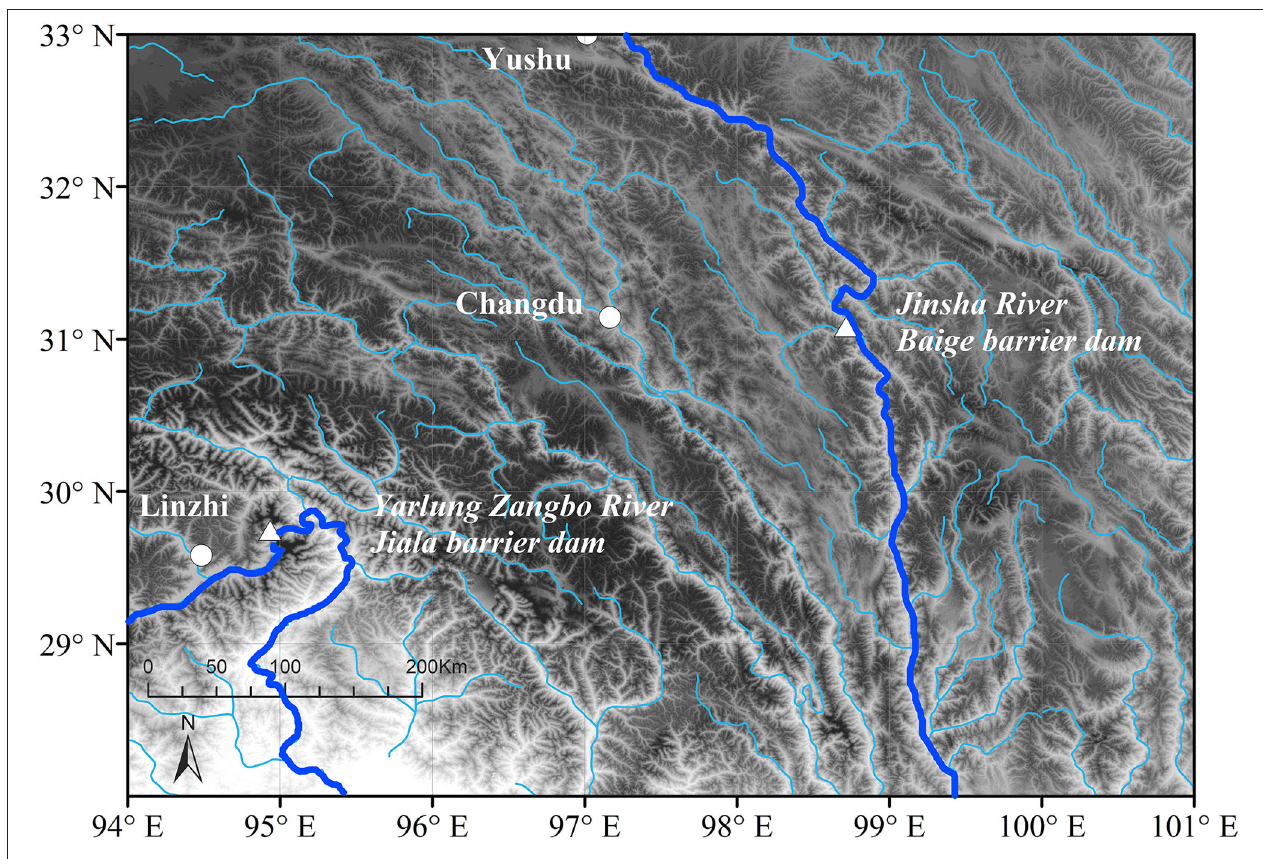
FIGURE 2 | Locations of the barrier lakes.